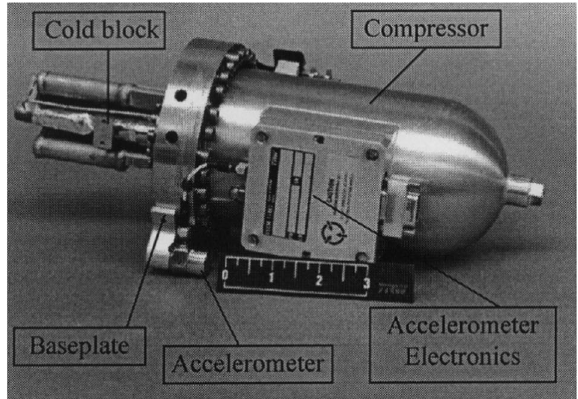
Figure 8. TRW miniature pulse tube cooler 20 .